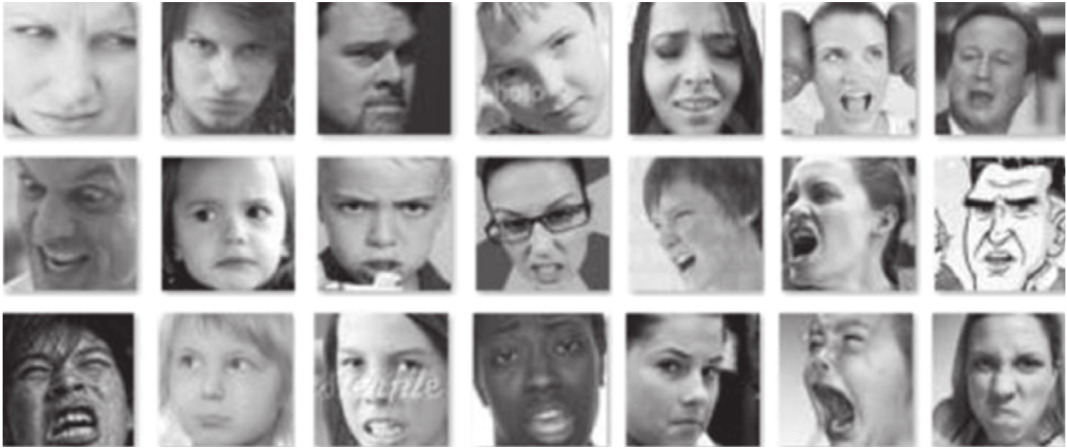
Figure 6: Example of FER2013 expression database.